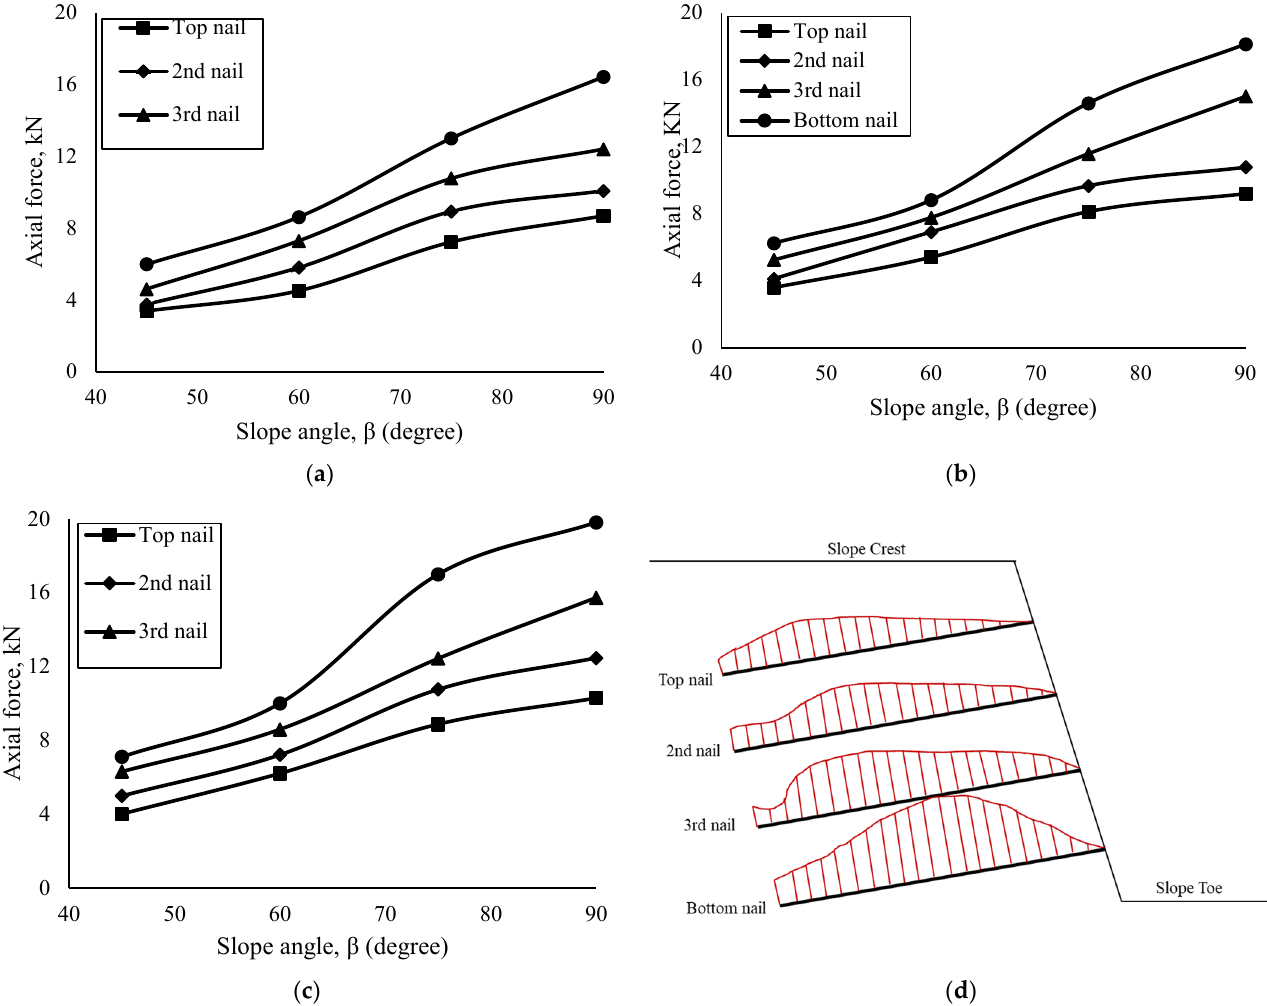
Figure 10. Variation of nail forces with slope angles for different backslopes: ( a ) α = 0°, ( b ) α = 10°, and ( c ) α = 20°; ( d ) distribution of nail force for slope angle 60° and α = 0°.